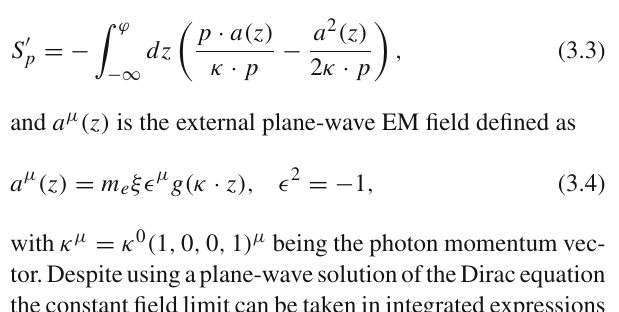
Fig. 4 Relationship between the energy of the emitted ALP and the polar angle at which it is emitted in lab frame for | (cid:14) p | = m e and various ALP